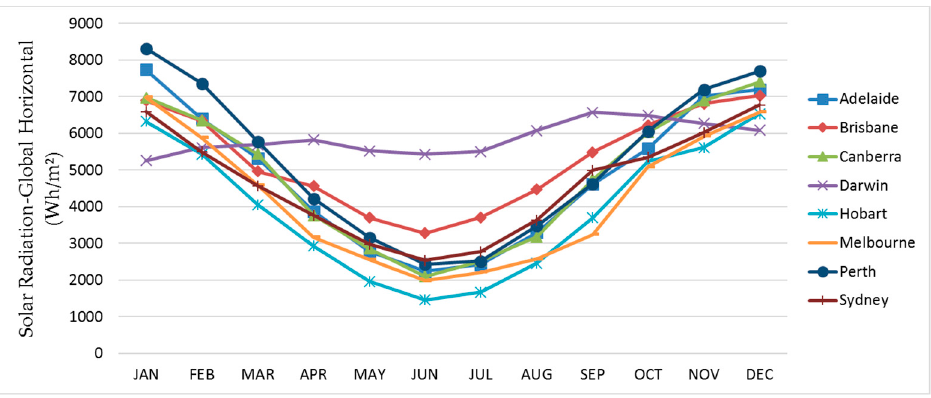
Figure 3. Solar irradiance for each capital city. Table 1. Climatic indicators for Australian capital